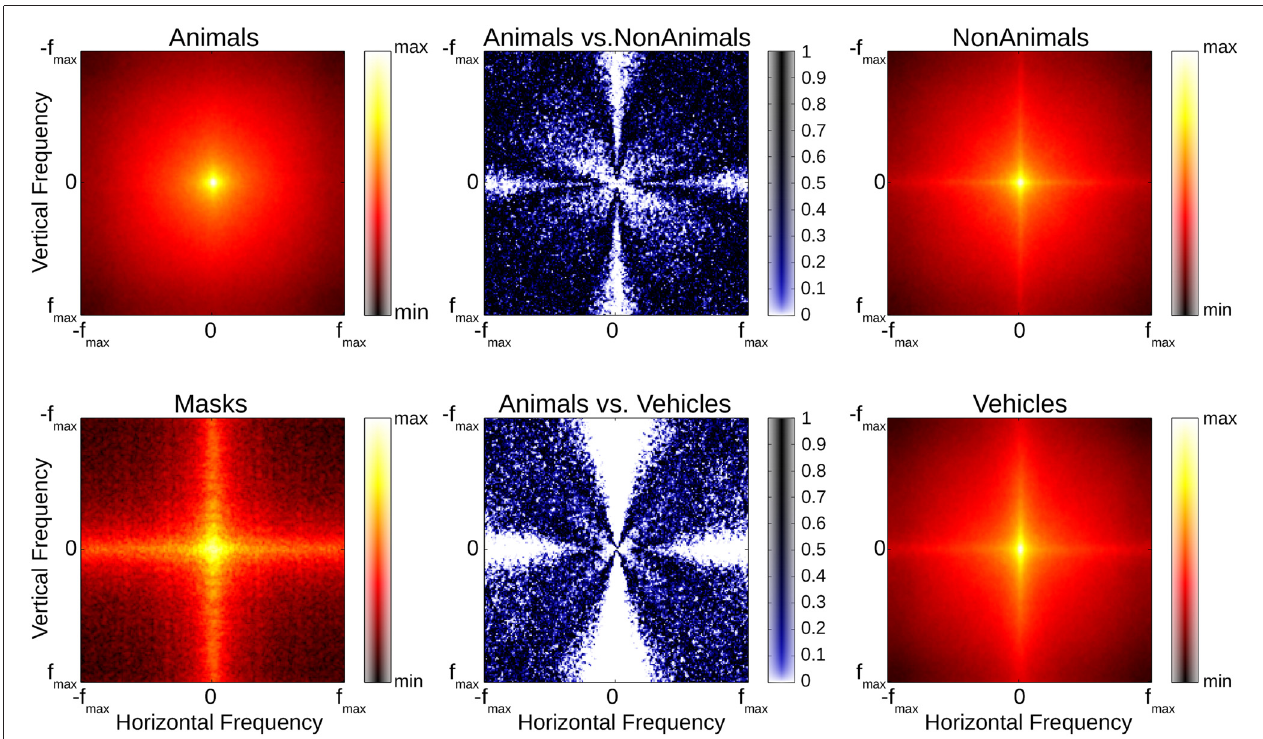
FIGURE 10 | Red/Black plots: averaged amplitude spectra of animal, non-animal, vehicle and mask stimuli (common scale). Blue/White plots illustrate differences between stimulus classes (Kolmogorov-Smirnov-tests, computed separately per orientation and frequency